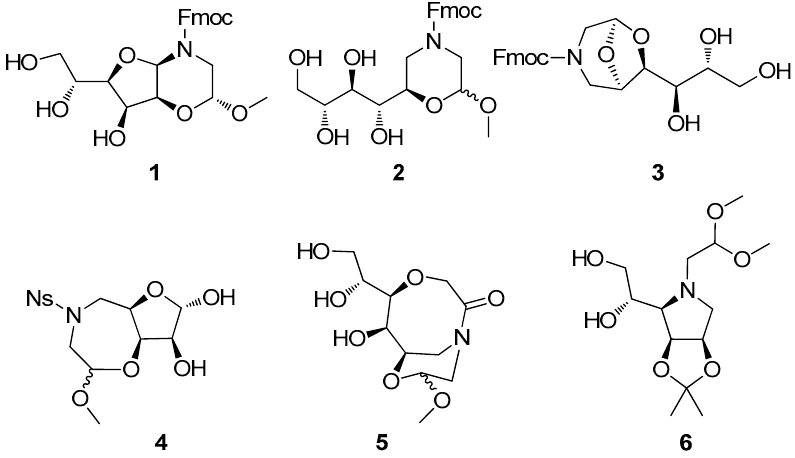
Figure 2. Polyhydroxylated nitrogen-containing scaffolds derived from D -mannose and glycine-derived aminoacetaldehyde.